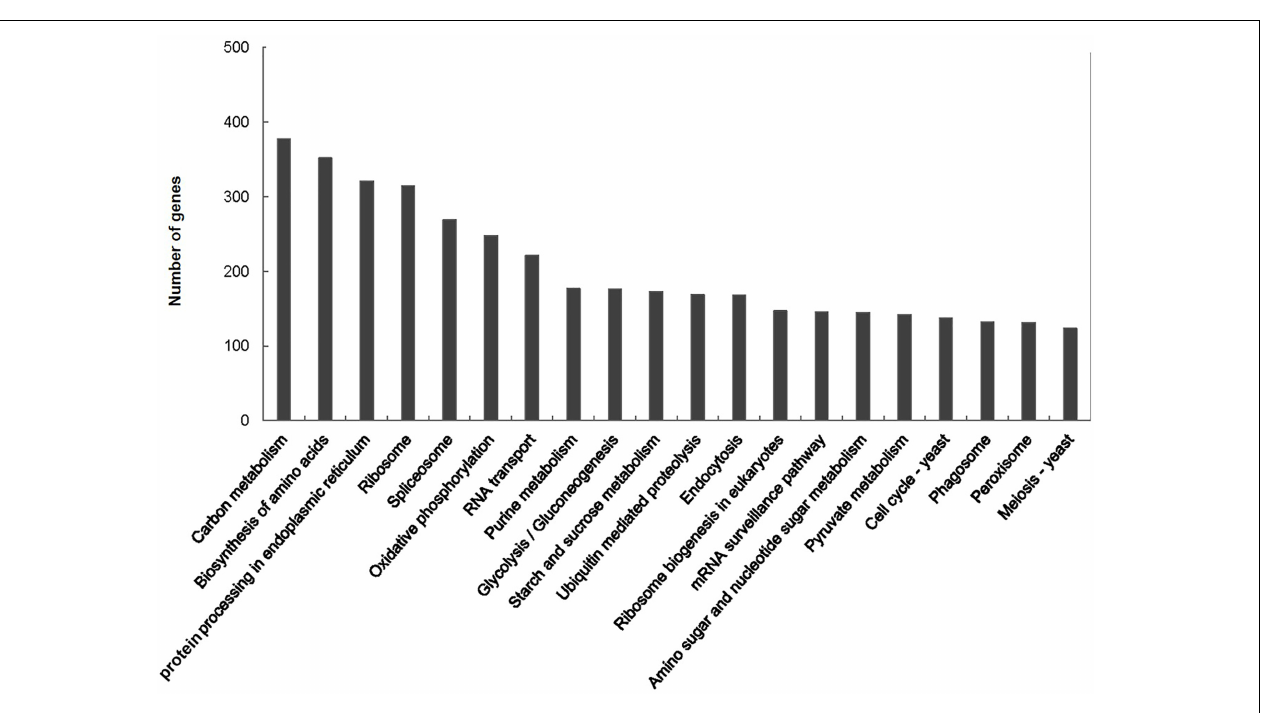
data, except for CF, was calculated using POPGENE v.